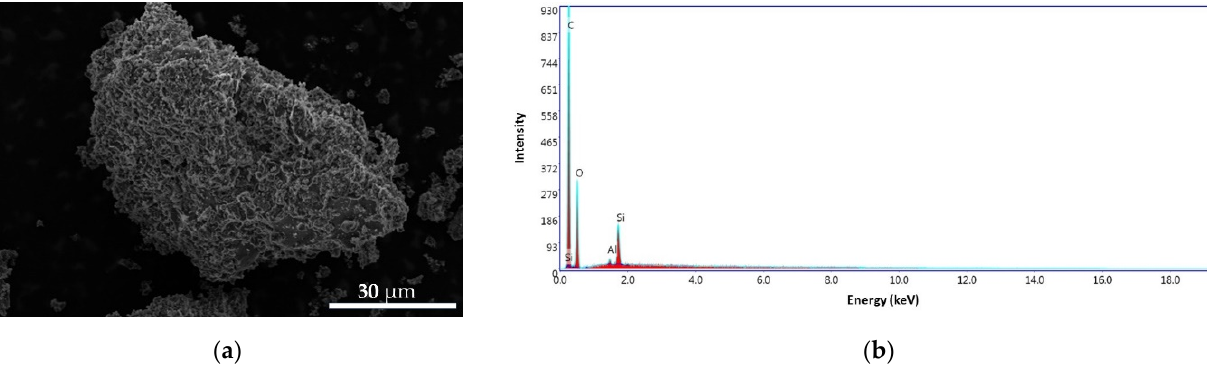
Figure 15. SEM images for CS–BPA (1:1) microbeads at 4000× ( a ) and the EDS pattern ( b ).